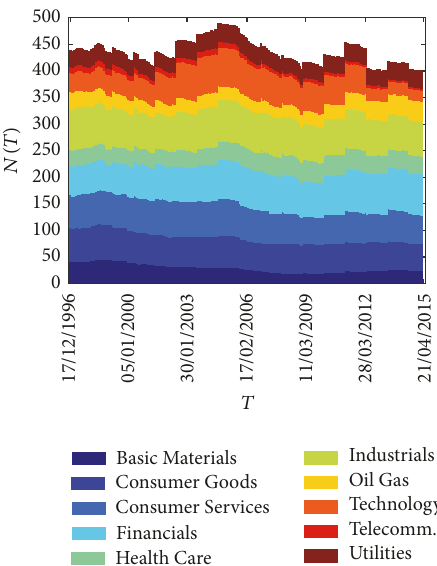
Figure 4: Number of stocks in each ICB industry in time. Number of stocks that are continuously traded in each time window together with their partition in terms of ICB